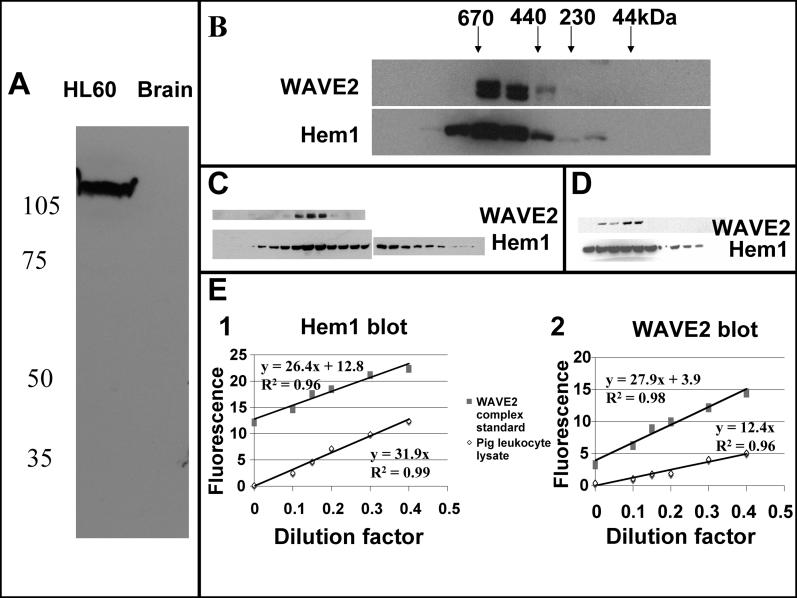
Hem-1 Component of WAVE Regulatory Complex Exists in Pools outside the WAVE2 Complex(A) Hem-1 antibody specifically recognizes Hem-1 and not the more ubiquitous Hem2/Nap125 homolog. Western blot of equal amounts of differentiated HL-60 (human neutrophil-like cell) and mouse brain lysate with antibodies directed against Hem-1. The Hem-1 antibody also fails to react against 293 lysates (data not shown).(B) Gel filtration of neutrophil-like HL-60 cell lysate blotted for Hem-1 and WAVE2. Note that both proteins migrate primarily as large complexes that generally cofractionate, but Hem-1 is also present in high-molecular-weight fractions that are devoid of WAVE2. The positions of molecular weight standards (thyroglobin, ferritin, catalase, and albumin) are noted.(C, D) Chromatograms of leukocyte lysate during WAVE2 complex purification. The WAVE2 complex was purified from pig leukocytes using conventional chromatography and antibodies to WAVE2 to determine which fractions to pool.(C) HiTrap S chromatogram (of 0% to 40% ammonium sulfate cut of pig leukocyte lysate) blotted for Hem-1 and WAVE2. Note a broader distribution of Hem-1 versus WAVE2.(D) HiTrap Q chromatogram (of the peak WAVE2 fractions from the HiTrap S column) blotted for Hem-1 and WAVE2. Note a broader distribution of Hem-1 versus WAVE2. Subsequent chromatography of the WAVE2-reactive fractions from the Q column yields superimposable profiles for Hem-1 and WAVE2 are (data not shown).(E) Quantitation of Hem-1 and WAVE2 in pig leukocyte lysates. Partially purified WAVE2 complex was used to quantitate relative concentrations of Hem-1 and WAVE2 in pig leukocyte lysates. The ratio of all of the components of the WAVE2 complex is 1:1 in the purified complex. Protein concentrations can be determined by fitting a single point to a standard curve or by comparing two dilution series to one another. The latter is a more accurate means to calculate protein concentration. When plotted from 0× to 1× dilution on the x-axis, the ratio of the slopes of two dilution series indicates their relative concentrations. The WAVE2 complex was serially diluted into pig leukocyte lysate (top curves—dilution into lysate is necessary because some proteins blot differently in buffer versus lysate) or pig leukocyte lysate was serially diluted into buffer (bottom curves). Both blots (Hem-1 and WAVE2) are from the same dilution series and the same gel. For this experiment, 14.8 nM WAVE2 complex standard and 1:20 pig leukocyte lysate represent 1× dilution (from which the 0.1×, 0.2×, 0.3×, and 0.4× dilutions were prepared). The relative slopes of the curves in each blot indicate concentration of proteins in the lysate versus the WAVE2 standard. Thus, for this experiment, the Hem-1 concentration in pig leukocyte lysate (E1) is 31.9/26.4 or 1.2× the concentration of the WAVE2 complex standard. Thus, 1.2 × 14.8 (concentration of Hem1 in Wave2 complex standard) × 20 (dilution factor of pig lysate) = approximately 360 nM Hem-1 in a 1× pig leukocyte lysate. Similarly, WAVE2 (E2) is 12.4/27.9 or 0.45× the concentration of the WAVE2 complex standard. Thus, 0.45 × 14.8 (concentration of WAVE2 in 2 complex standard) × 20 (dilution factor of pig lysate) = approximately 130 nM WAVE2 in a 1× pig leukocyte lysate. Curves represent averages of experiments performed in duplicate.